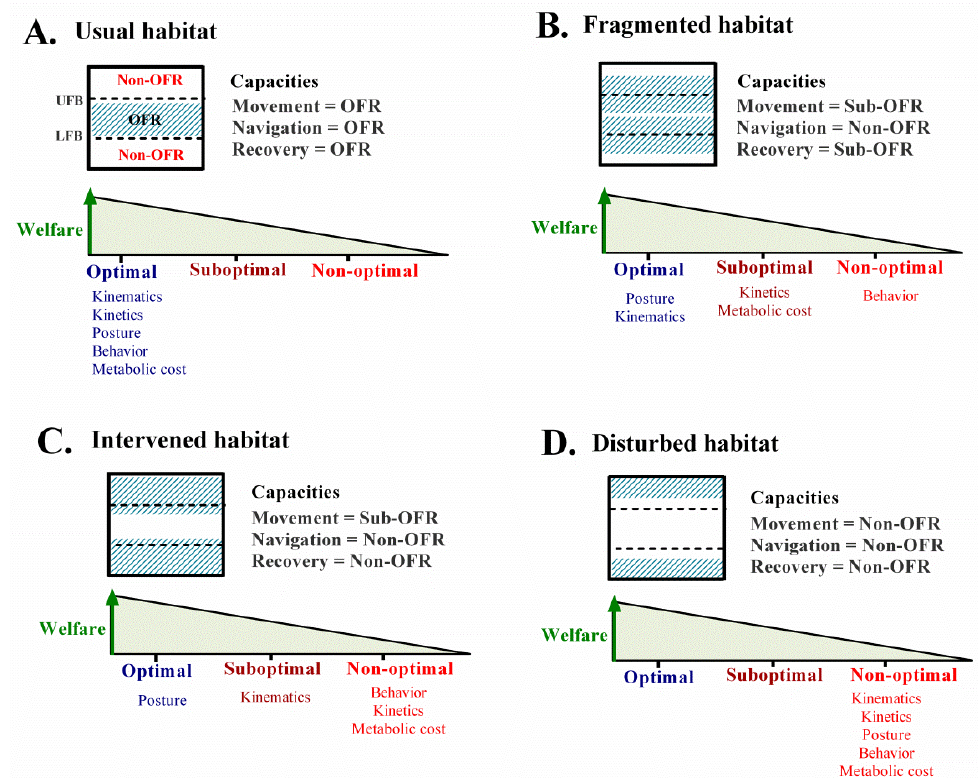
Figure 3. The methodology used for the integrative analysis of the functional ranges for movement, navigation, and recovery capacities according to different environmental conditions. The functional integration diagram for welfare status (above) and the quality of the movement parameters (below) are shown for each environment. ( A ). Usual habitat. Food resources, places of protection, and usual environmental conditions in which all capacities are completely within the functional boundaries, which is understood as the optimal functional range (OFR). ( B ). Fragmented habitat. There are sufficient resources and adequate protection sites; however, these are dispersed in the habitat. The navigation capacity is non-OFR. The movement capacity is in the OFR with respect to posture and kinematics and in the non-optimal functional range (non-OFR) with respect to kinetics. This is called sub-OFR. The recovery capacity presents as within the sub-OFR. ( C ). Intervened habitat. There are limited resources, places of protection, and adequate environmental conditions. The navigation and recovery capacities present are in the non-OFR. The movement capacity is in the sub-OFR; in the Non-OFR for kinematics, kinetics, and metabolic cost; in the OFR only for posture. ( D ). Disturbed habitat. There are limited resources, scarce places of protection, and unpredictable environmental conditions. The movement, navigation, and recovery capacities are present in the non-OFR. The dotted lines represent the upper (UFB) and lower functional boundaries